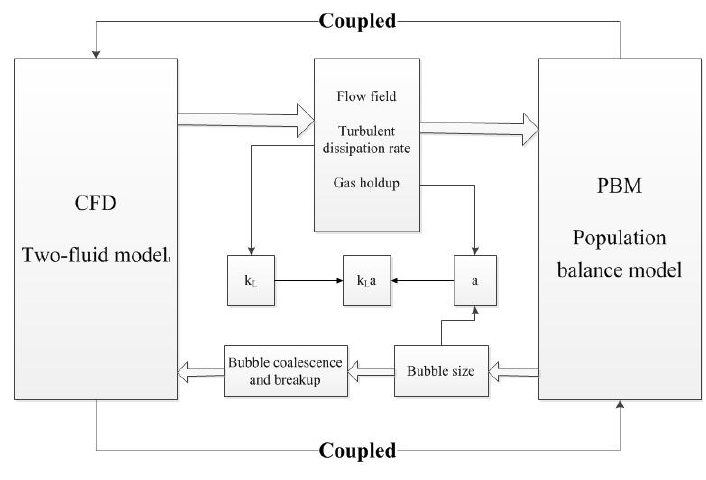
Figure 8. The diagram of the computational fluid dynamics-population balance model (CFD-PBM) coupled model.